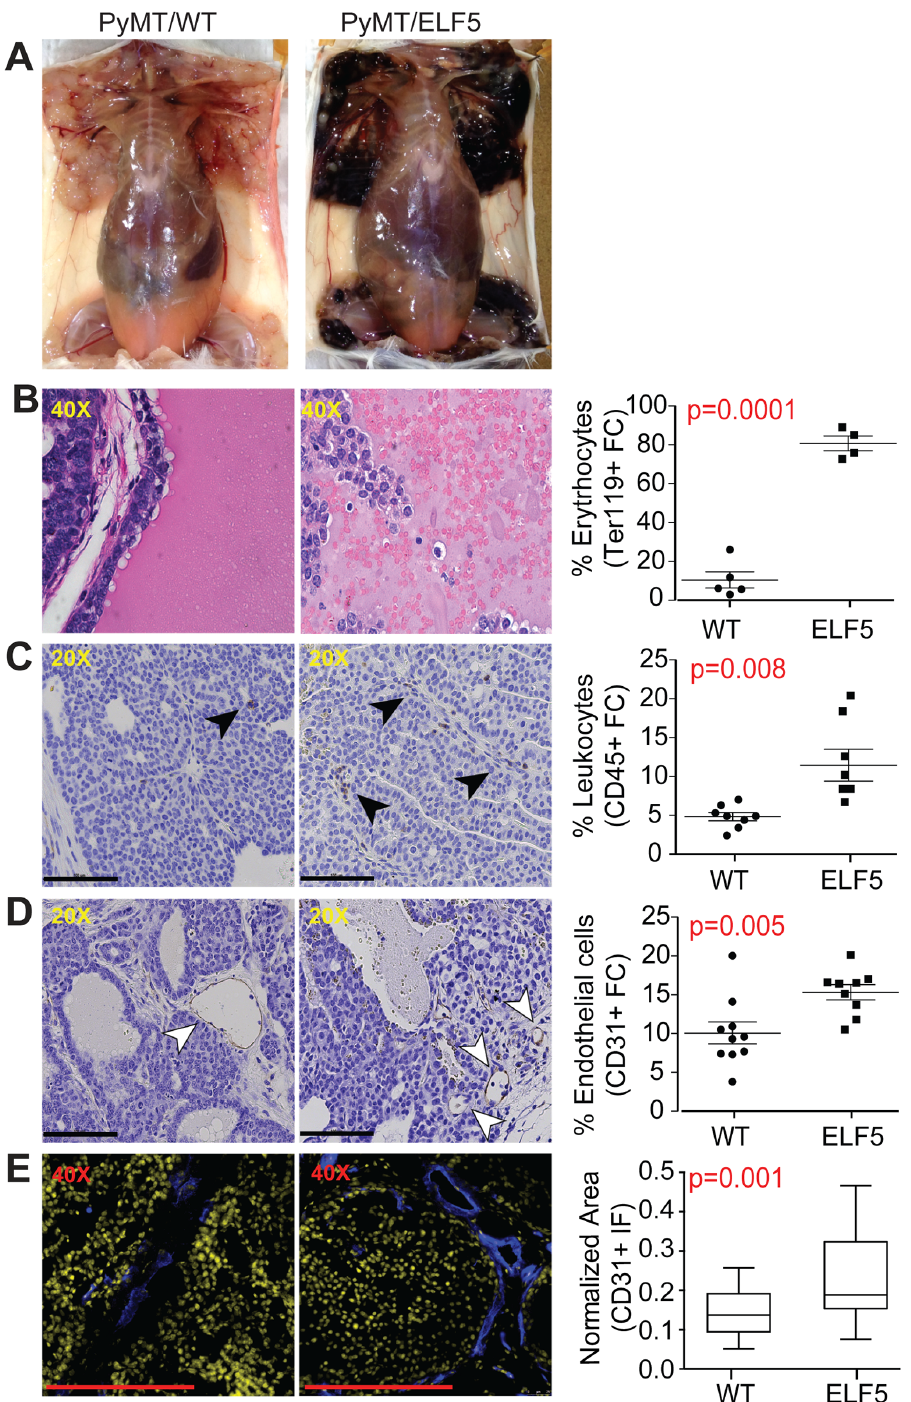
Fig 2. ELF5 produces hemorrhagic mammary tumors and increased tumor vasculature. Panel A , appearance of PyMT-driven tumors in WT mice or those experiencing long-term (8 wk) forced expression of Elf5. Panels B – D , increased presence of erythrocytes (H&E), leukocytes (black arrows), and endothelial cells (white arrows), respectively (immunohistochemistry [IHC]), driven by ELF5, (scale bars 100 μ m). Flow cytometric (FC) quantification of these effects is shown in the right-hand side (RHS) panels. Panel E , measurement by immunofluorescence (IF) of CD31+ endothelium area (blue) in relation to the total cell area stained by DAPI (yellow). ImageJ quantification of random fields is shown in the RHS panel.